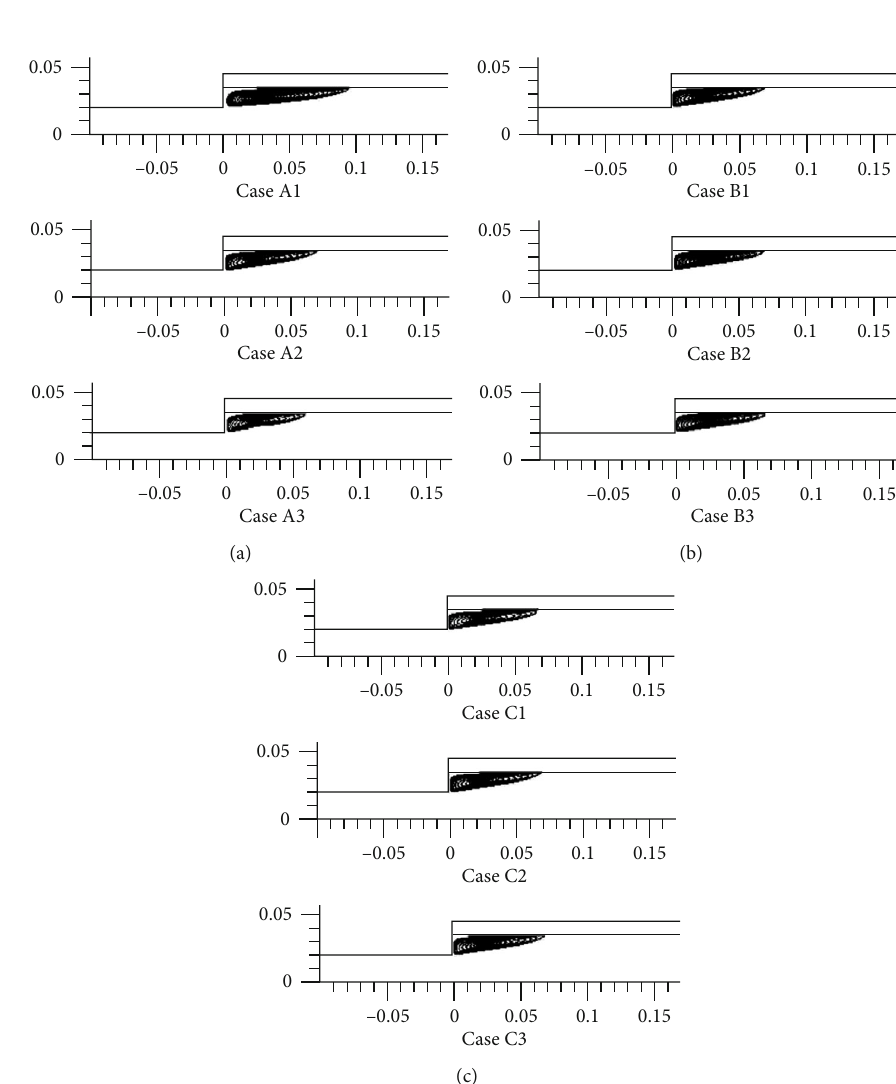
Figure 9: Temperature distributions of the fl ame surface.